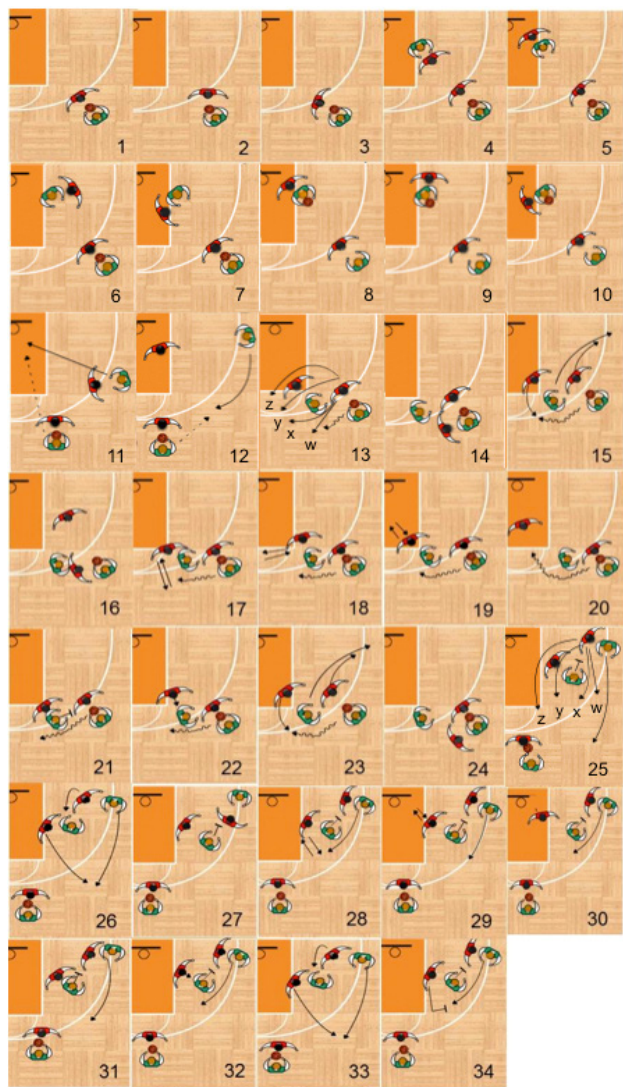
Figure 1. Basketball court diagrams with patterns of SCDs-SPDs couples in 1x1, 2x2 and 3x3 interactions, where: continuous arrows: displacements without ball; zigzag arrows: displacements with ball; dotted arrows: pass action; T-shape straight line: screen. In diagrams 13 and 25: ‘w’: follow thru; ‘x’: follower; ‘y’: third; ‘z’: